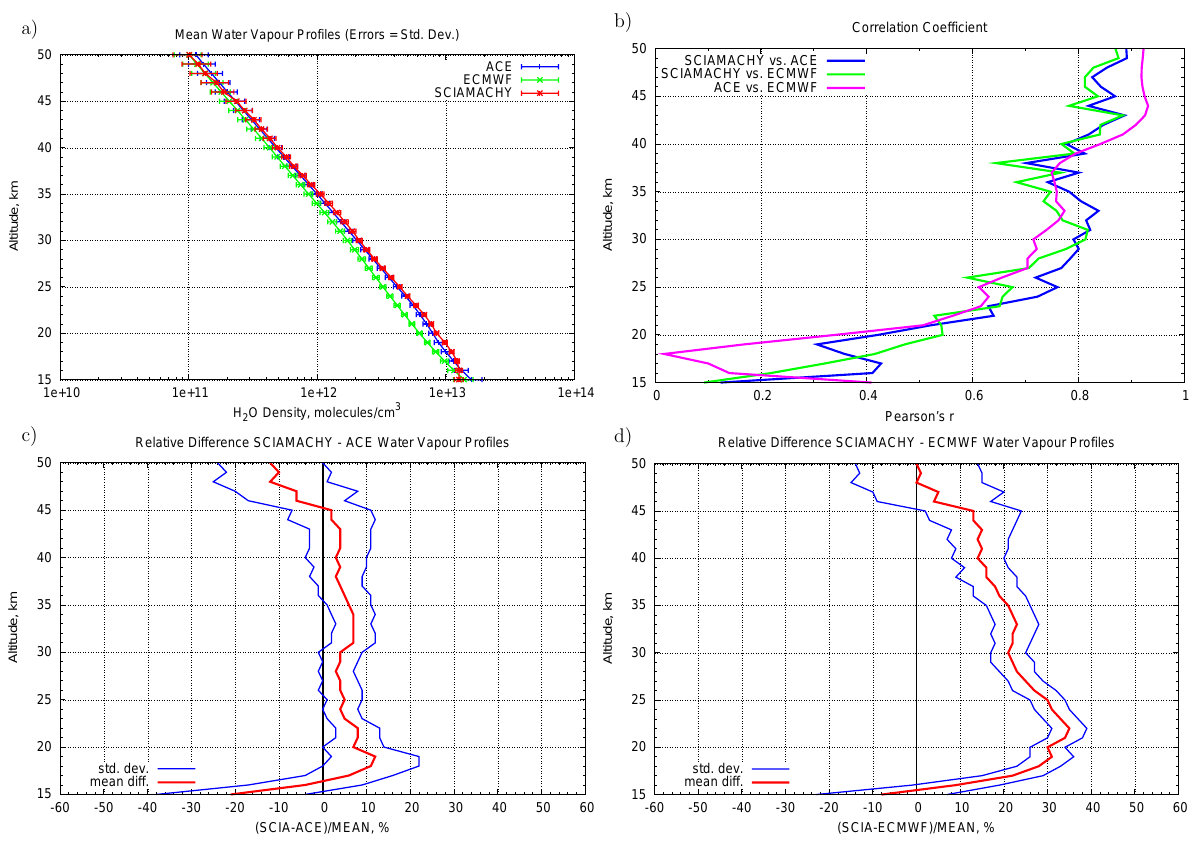
Fig. 8. Results of comparison between 408 collocated SCIAMACHY, ACE-FTS and ECMWF water vapour profiles. (a) Mean profiles; the error bars denote the standard deviation of the profiles. (b) Correlation between profiles as function of altitude. (c) Mean relative deviation between SCIAMACHY and ACE-FTS profiles and corresponding standard deviation. (d) As (c), but for comparison with ECMWF